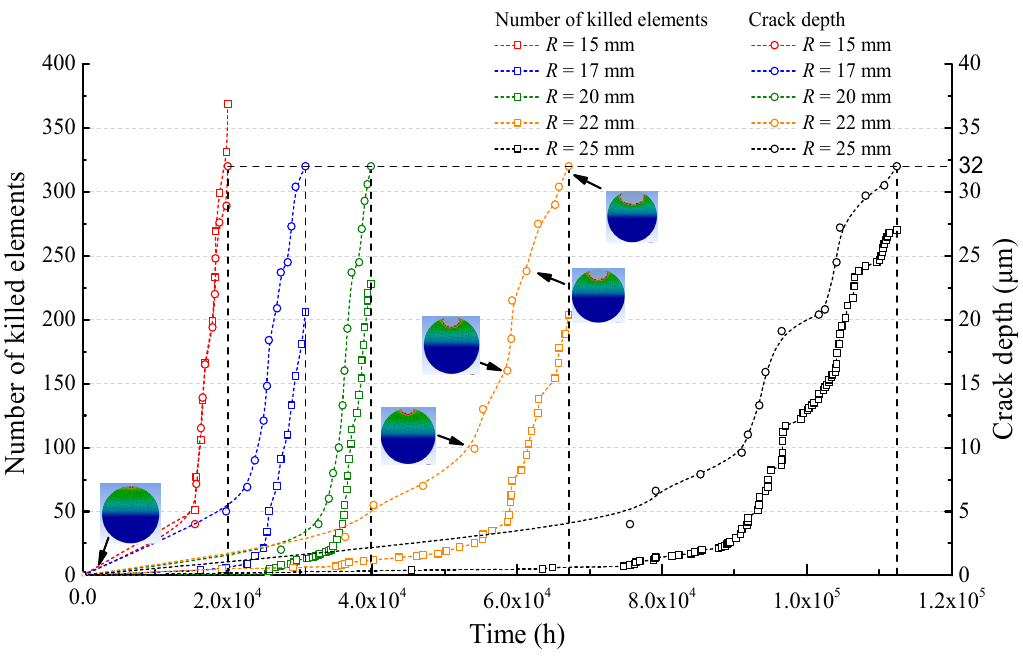
Figure 7. Crack depth and the number of killed elements vs time in the case of different bending radii R .